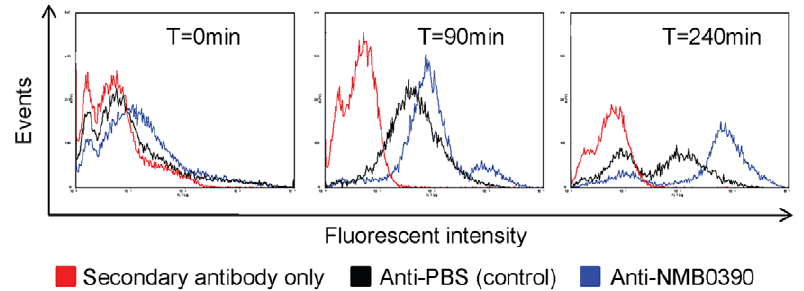
Figure 8. Schematic representation of amino acid variability of NMB0390 homologues from 25 N.meningitidis strains. Each vertical bar indicates number of strains carrying different amino acid compared to the consensus sequence of NMB3090 homologues at a position indicated by x-axis. Y-axis indicates number of strains. Strain information is provided in Table 6.